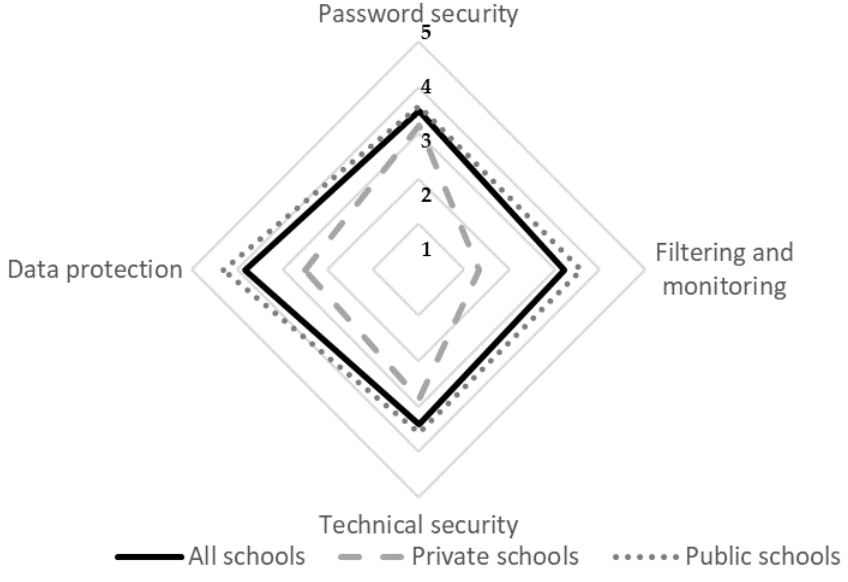
Figure 2. Strands 1 and 2 of Element B.